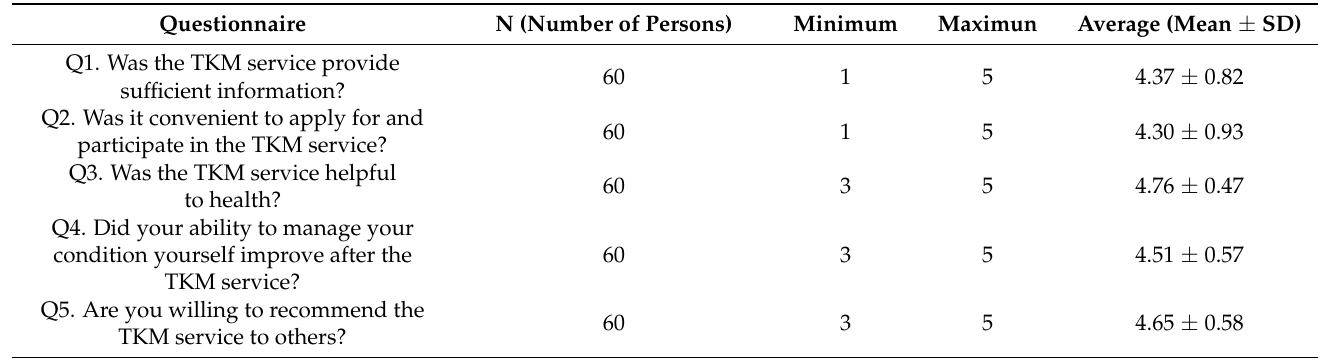
Table 3. Effectiveness of TKM Services.